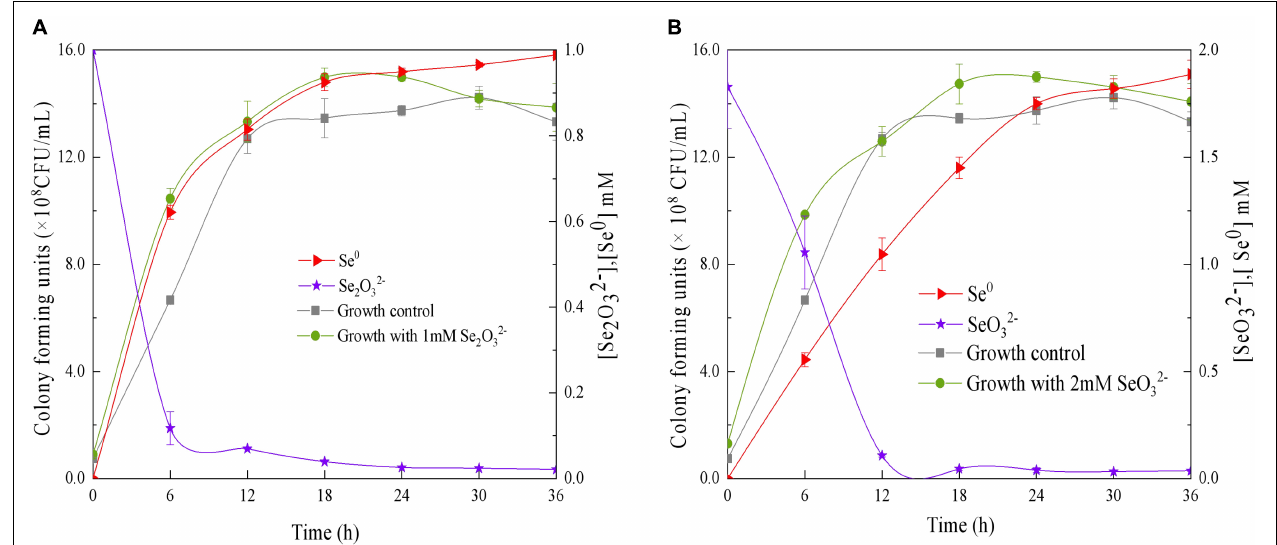
FIGURE 4 | Time courses of bacterial growth, SeO 3 2 − removal, and Se 0 formation by the strain Proteus mirabilis QZB-2 grown in LB medium containing 1 mM (A) and 2 mM (B) SeO 32 − .